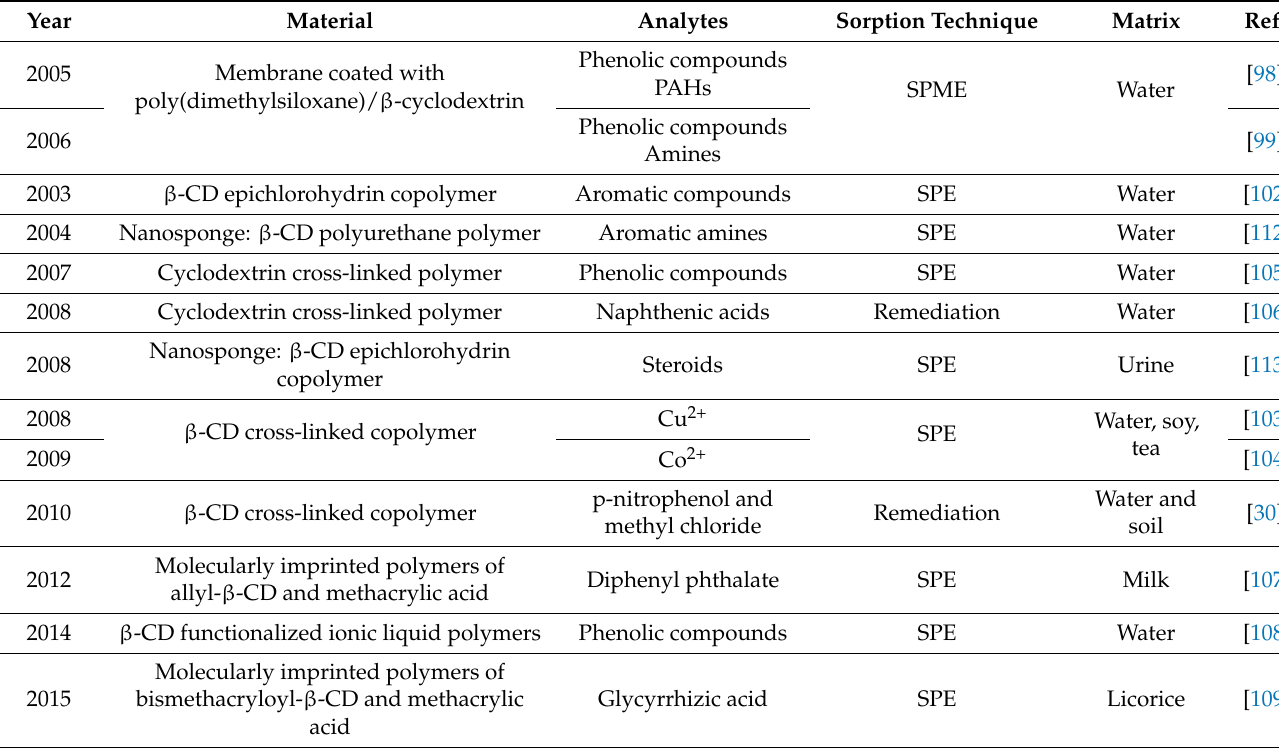
Table 2. An overview of the reported studies on the use of organic-based supports with cyclodextrin for the adsorption of environmentally concerning